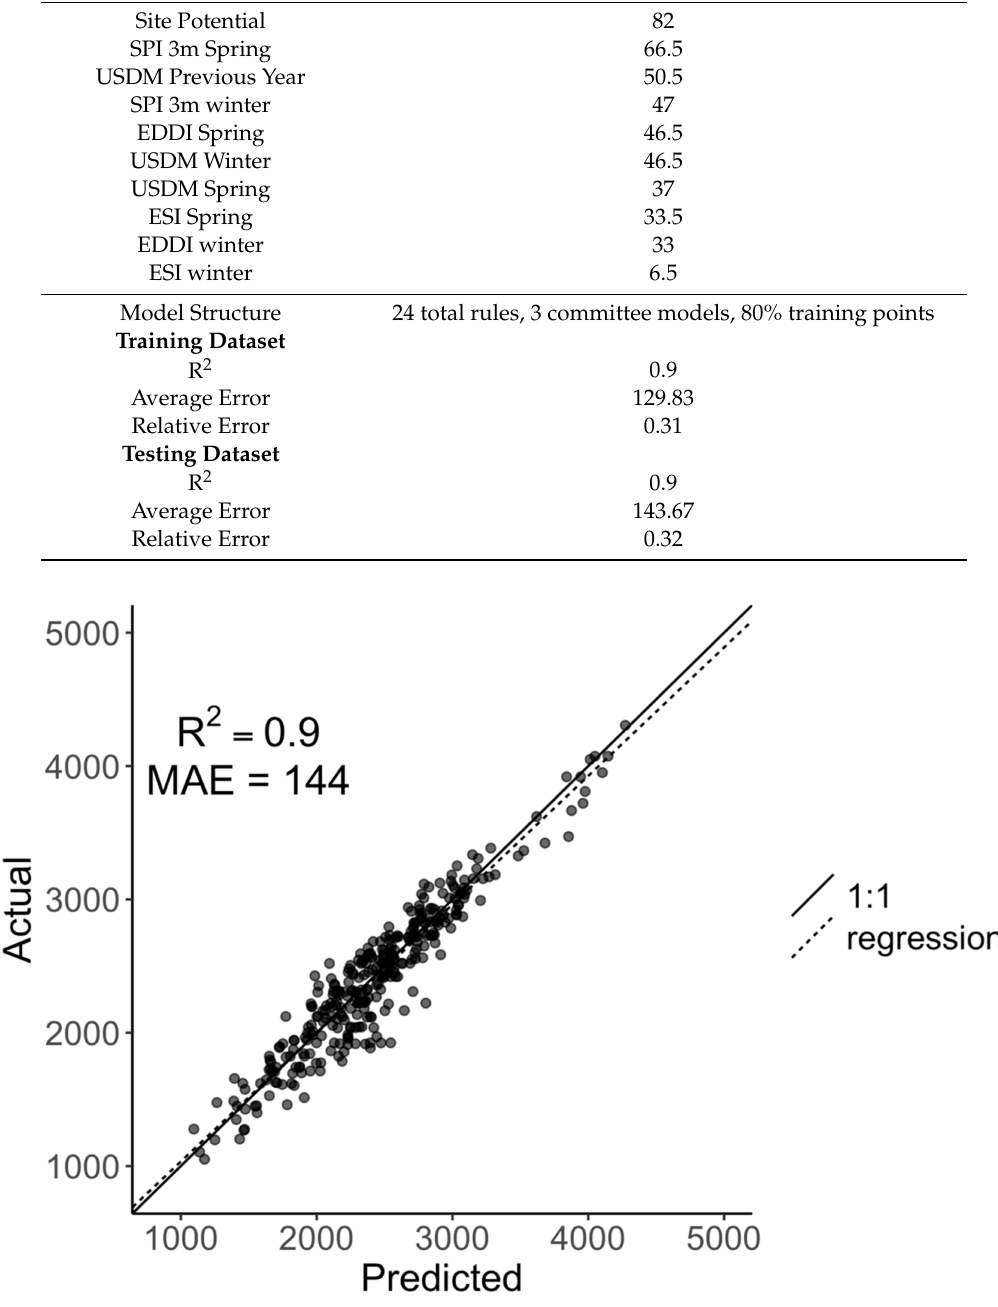
Figure 10. Evaluation of the predictive model performance on a testing dataset. The observed biomass is seen to have regressed on the predicted biomass; linear regression is displayed as a dashed line and the 1:1 line is a solid